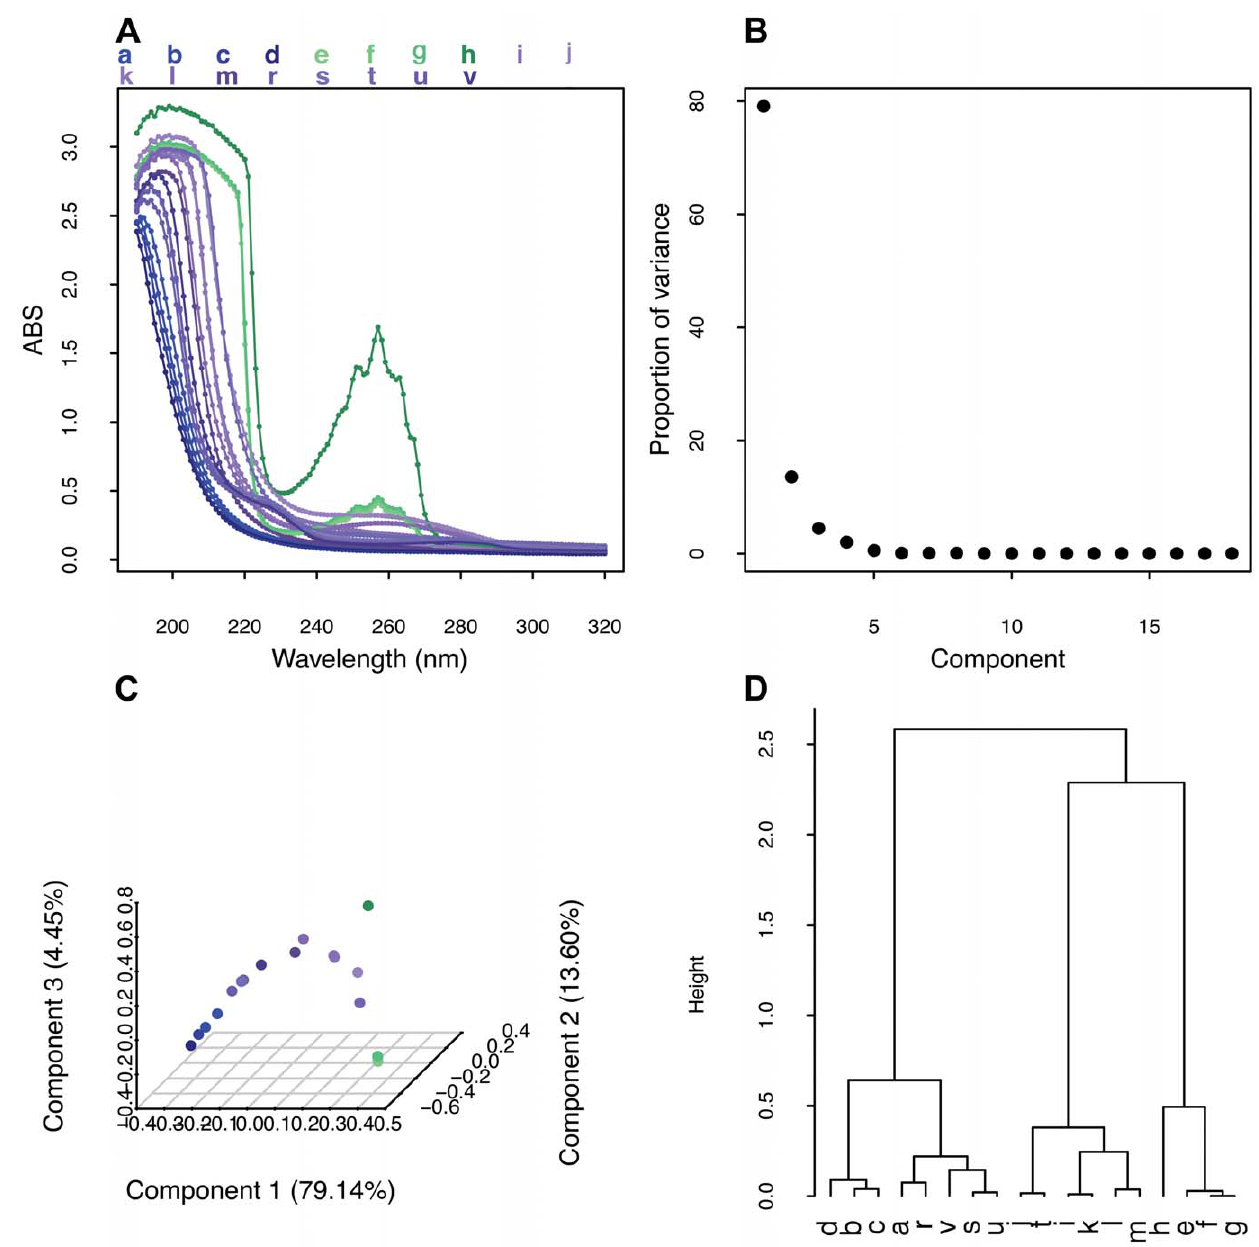
Figure 3. Multivariate analysis of UV spectra of heparins and other GAGs. ( A ) Overlay of GAGs scanning UV spectra. ( B ) Scree plot of components. ( C ) Plot of the first three components. ( D ) Hierarchical cluster analysis performed on the loading plot. Samples a–d represent pure heparin samples; e–h are the commercial contaminated heparins, i–k and t represent DS, C4S, C6S and HS respectively; l–m are SOSCS and IHC; r–s are heparin spiked with 5 and 10% of heparin-by product; u–v correspond to heparin spiked with 5 and 10% of